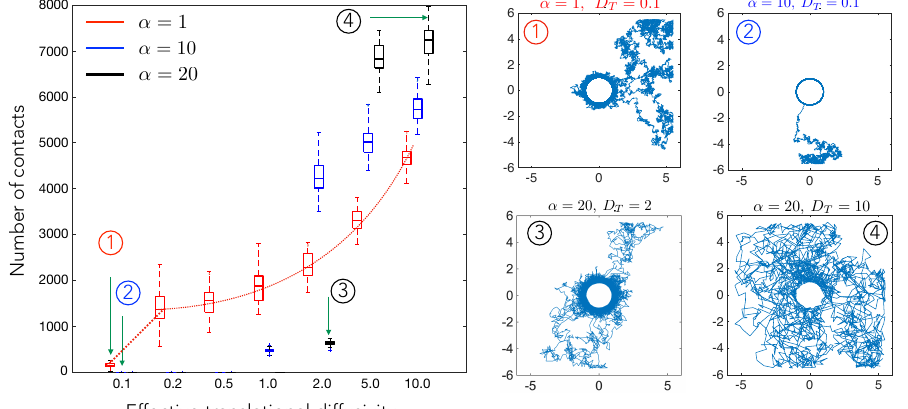
Figure 4. The number of cell–cell contact events in a fixed interval of time ( T = 1000) plotted here as a function of the scaled effective diffusivity, D T , which represents the random motility of cell B. Here, we show how the number of cell–cell contact varies for three different elastic interaction strength values, α , corresponding to substrates with three different stiffness. The highlighted points numbered from (1)–(4), show representative cell trajectories over long times and highlight how varying α and D T can yield states where the cells are in close proximity most of the time (low D T , high α ) or states where cells interact rarely (high D T , low α ). The interpretation of the box plots is the same as in Figure 2. The simulation was run for a total time of T = 1000 and updates in cell position were made every δ t =